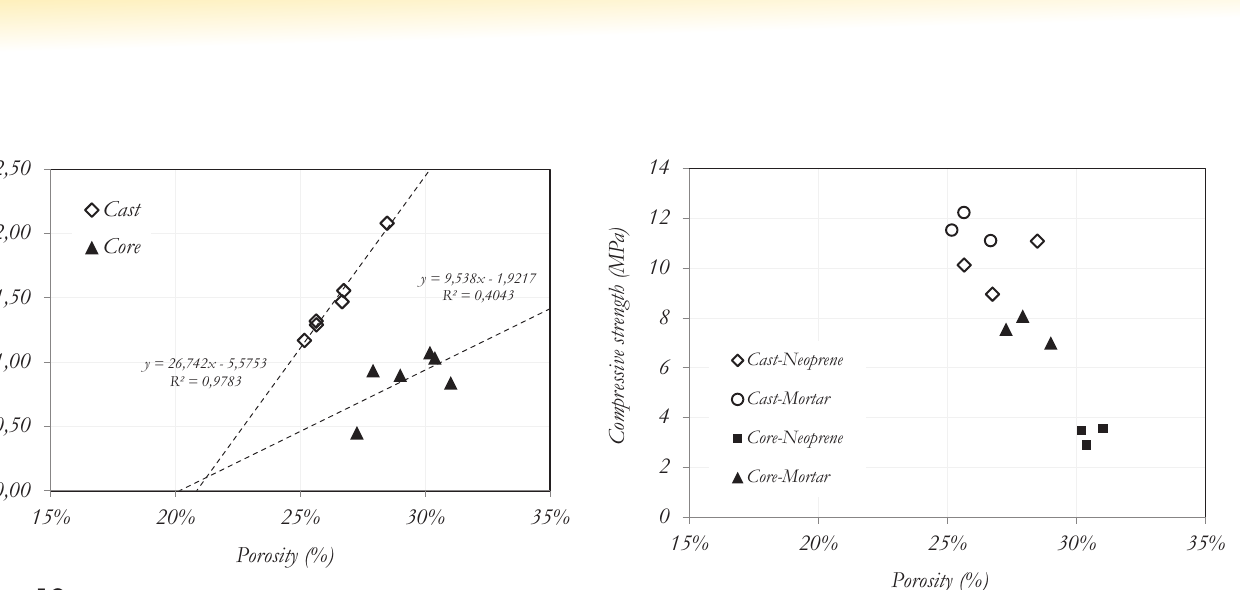
Table 3 Statistical results for compressive strength of cast and cored specimens Specimen type Mortar capping